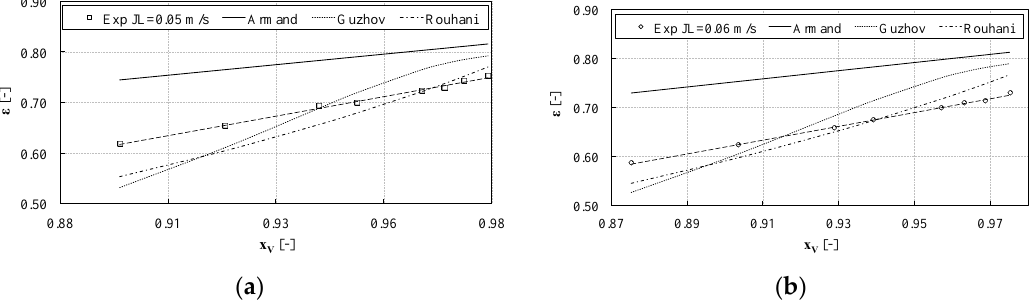
Figure 10. Experimental void fraction comparison with models ( a ) J L = 0.05 m/s and ( b ) J L = 0.06 m/s.